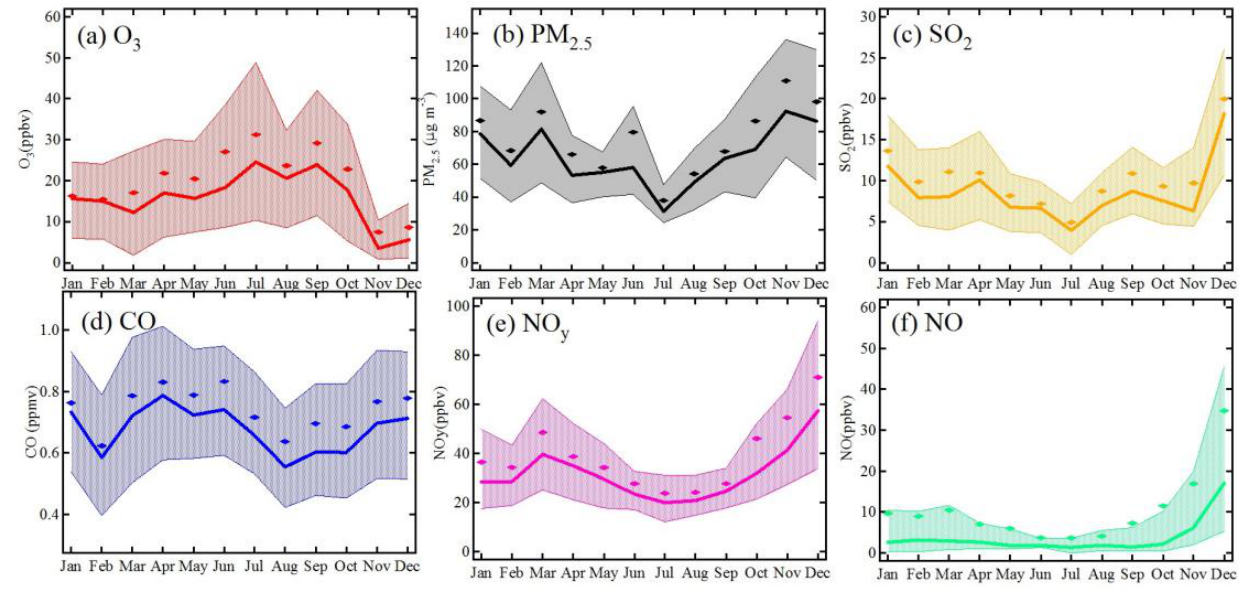
Fig. 3. Seasonal variation of (a) O 3 , (b) PM 2 . 5 , (c) SO 2 , (d) CO, (e) NO y and (f) NO. Bold solid lines are the median values, diamonds show Figure 3 . Seasonal variation of ( a ) O the monthly averages and thin solid lines represent percentiles of 75% and Bold solid lines are the median values, diamonds show the monthly averages and thin 3 solid lines represent percentiles of 75% and 25%.4